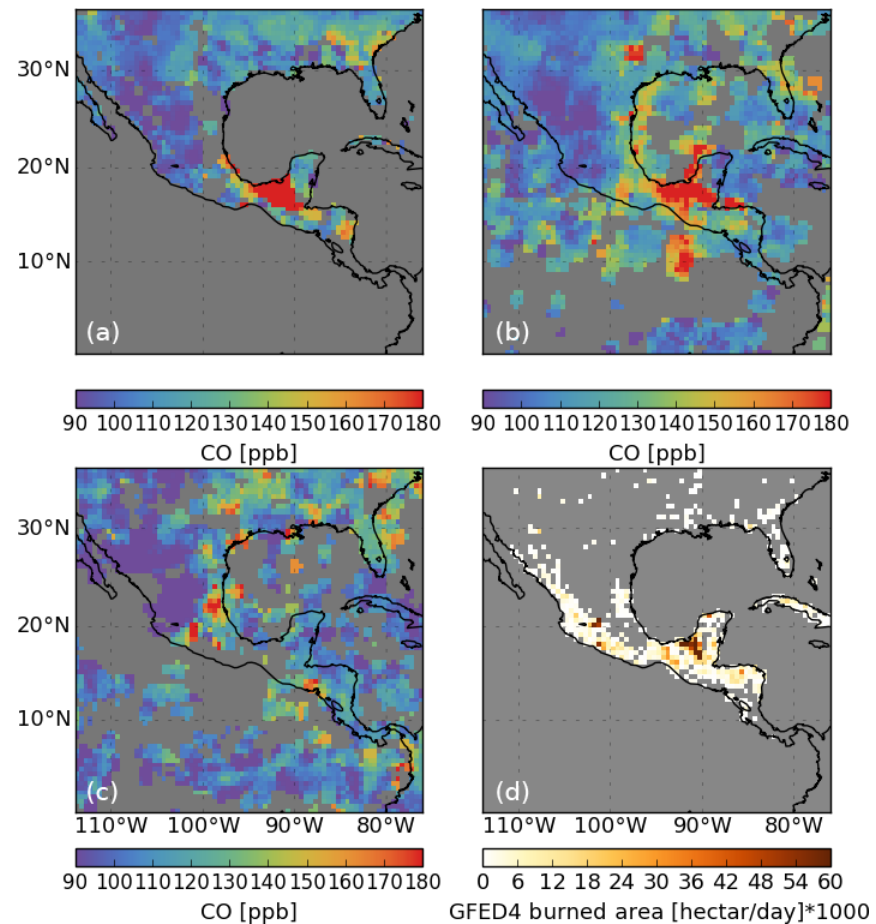
Figure 4. Same as Fig. 3, but the data are averaged from 1 April to 15 May 2003.